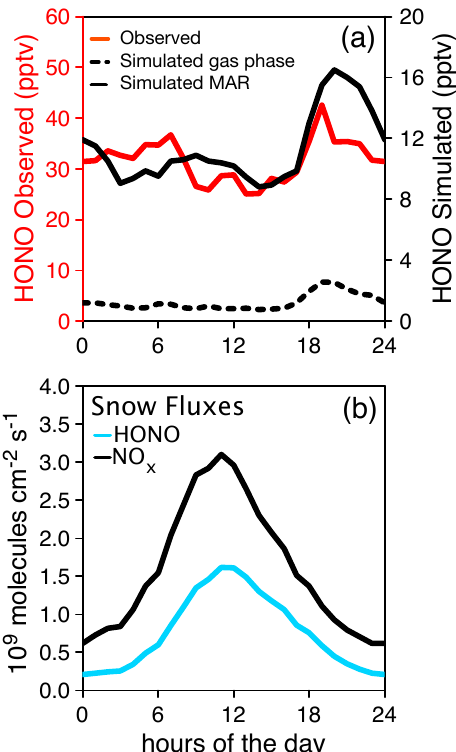
Figure 6. Top: measured (red line) versus simulated (black lines) (see Sect. 5) diurnal cycles of HONO mixing ratio at 1m height. Note the use of a different vertical scale for observations (left) and simulations (right). The black dashed line is the simulation made when considering only the gas-phase production of HONO from NO (without snow emissions). Bottom: diurnal NO x snow source derived from field observations at Concordia (Frey et al., 2014) to- gether with an estimated emission of HONO from snow based on laboratory snow irradiation experiments (see Sect.